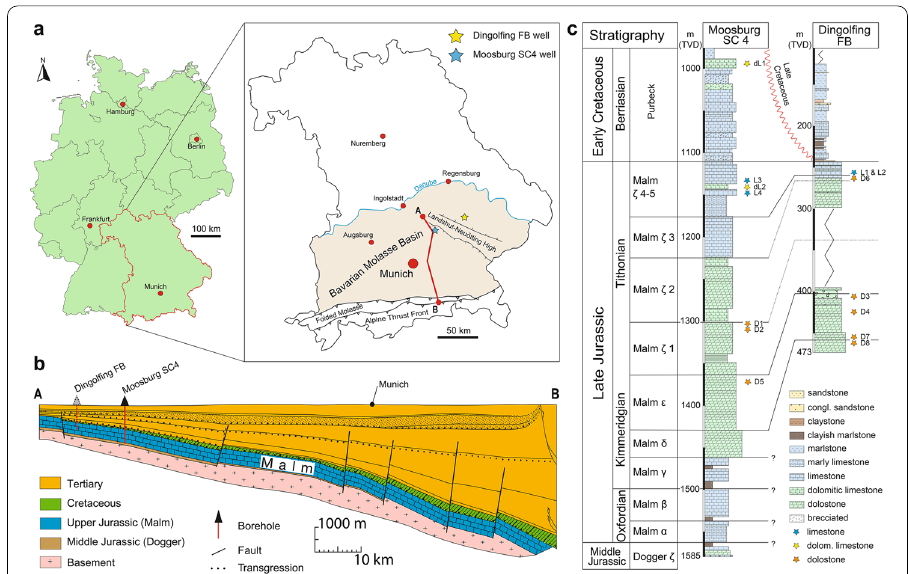
Fig. 2 Overview of the Bavarian Molasse Basin. a Map highlighting the position of the Bavarian Molasse Basin in Southern Germany and the two locations of exploration wells Dingolfing FB and Moosburg SC4. b Cross section through the Bavarian Molasse Basin (A–B like in a ) shows the increasing depth of the Upper Jurassic Malm deposits towards the south (from BayStMivt (2012) modified after Lemcke (1988)). c Lithological profiles from the two investigated exploration wells with subdivision into stratigraphic units and location of the studied rock samples from the drilling cores of the